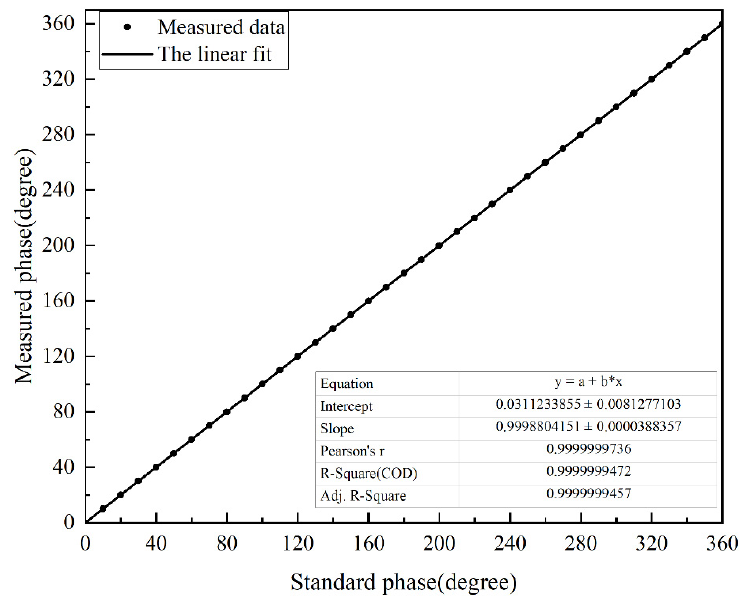
Figure 7. Fitted curve of apFFT measurement points.